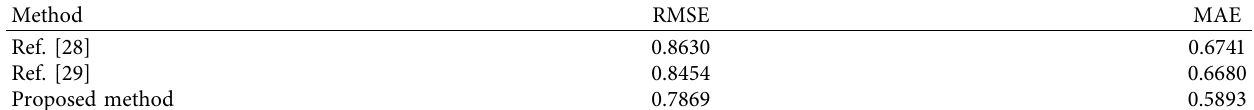
Table 4: Comparison of diferent methods under the MovieLens-1M dataset.